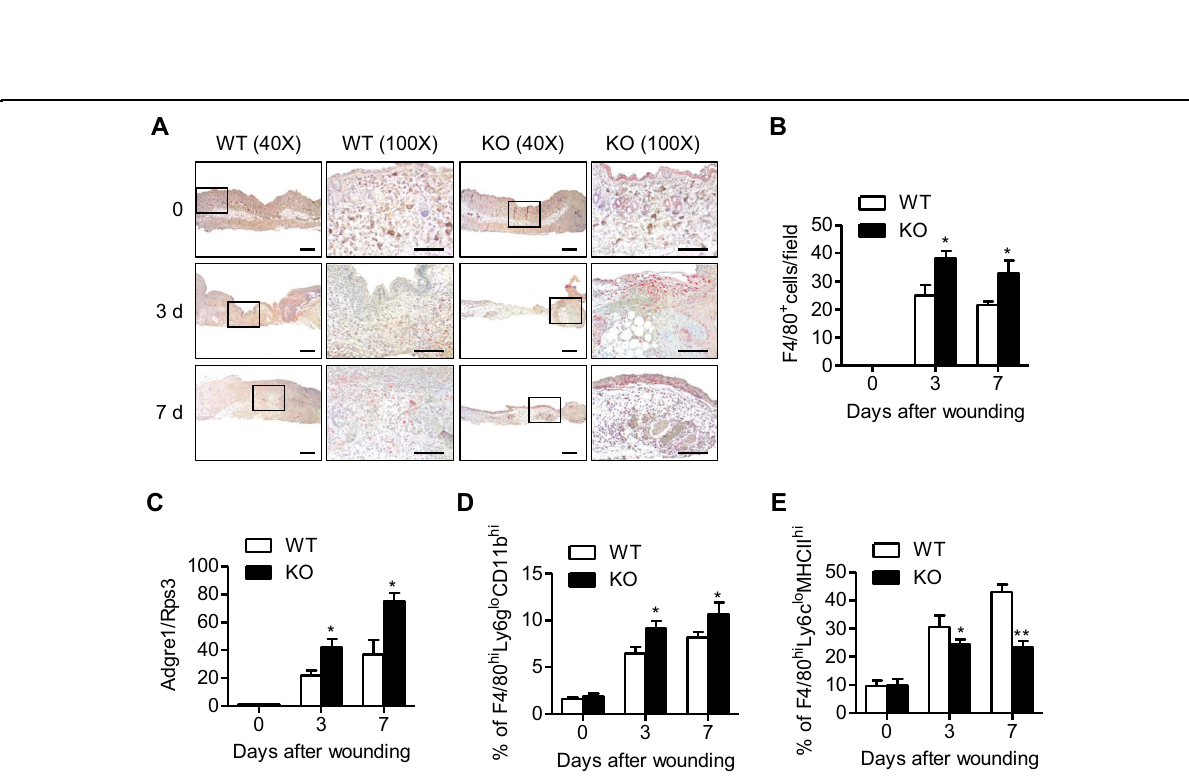
Fig. 2 Decreases in collagen deposition and angiogenesis in mS6KO mice. a Representative photomicrographs of wounds stained with Masson ’ s trichrome or immunostained with an anti-vWF antibody at 0 and 14 days after injury are shown (original magni fi cation, 200×). Bars = 50 μ m. b The mRNA levels of extracellular matrix-related genes in wounds were determined by real-time RT-PCR ( n = 8). c Skin wounds of WT and KO mice were double stained for vimentin and α -SMA expression to identify myo fi broblasts. The vimentin and α -SMA-positive cells were counted in sections of the wounds harvested on day 14 ( n = 6). Values represent the mean ± SEM. * p < 0.05 and ** p < 0.01 vs. WT